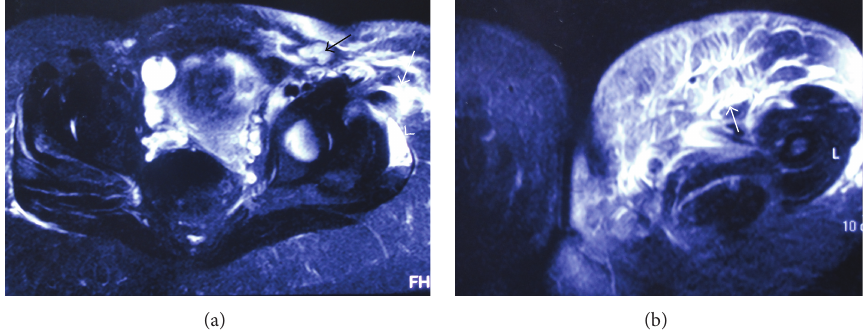
Figure 1: ((a)-(b)) Axial T2W images at the level of acetabulum (a) and upper thigh (b). White arrows show high signal areas at the soft tissues of the anteromedial part of left thigh, indicating inflammatory process. White arrowhead shows high signal within the fascia next to the left gluteus maximus muscle. Inflammatory lymph node is seen at the left groin (black arrow).